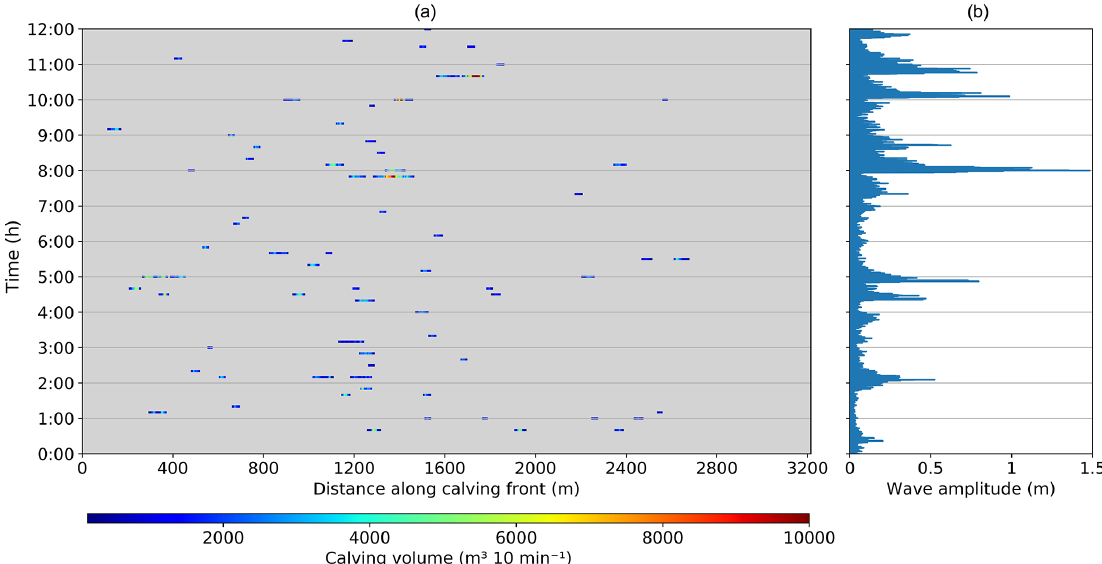
Figure 11. Comparison between pressure-sensor-derived wave amplitudes (b) and detected calving events (a) for a 12h period on 25 August. Big calving events are clearly visible in both data